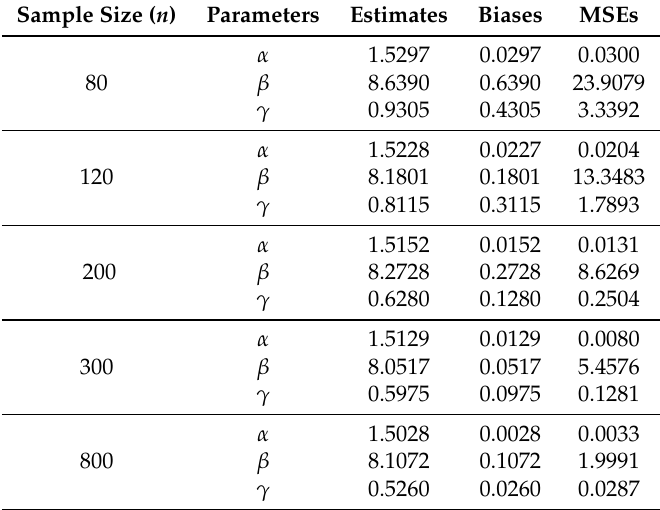
Table 6. Average MLEs biases and MSEs for α = 1.5, β = 8 and γ =